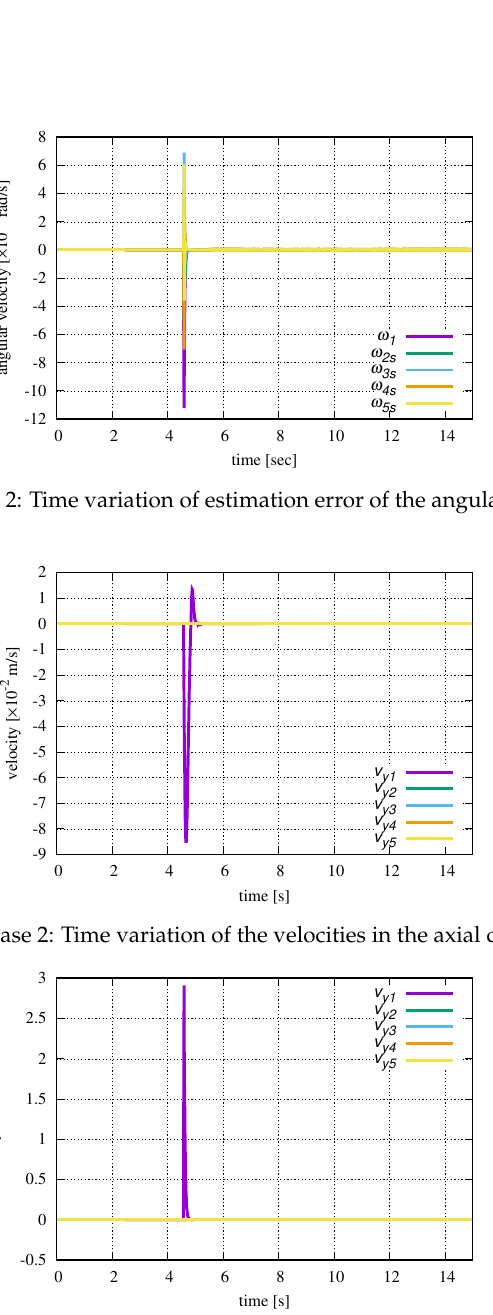
Figure 26. Case 2: Time variation of estimation error of the velocities in the axial